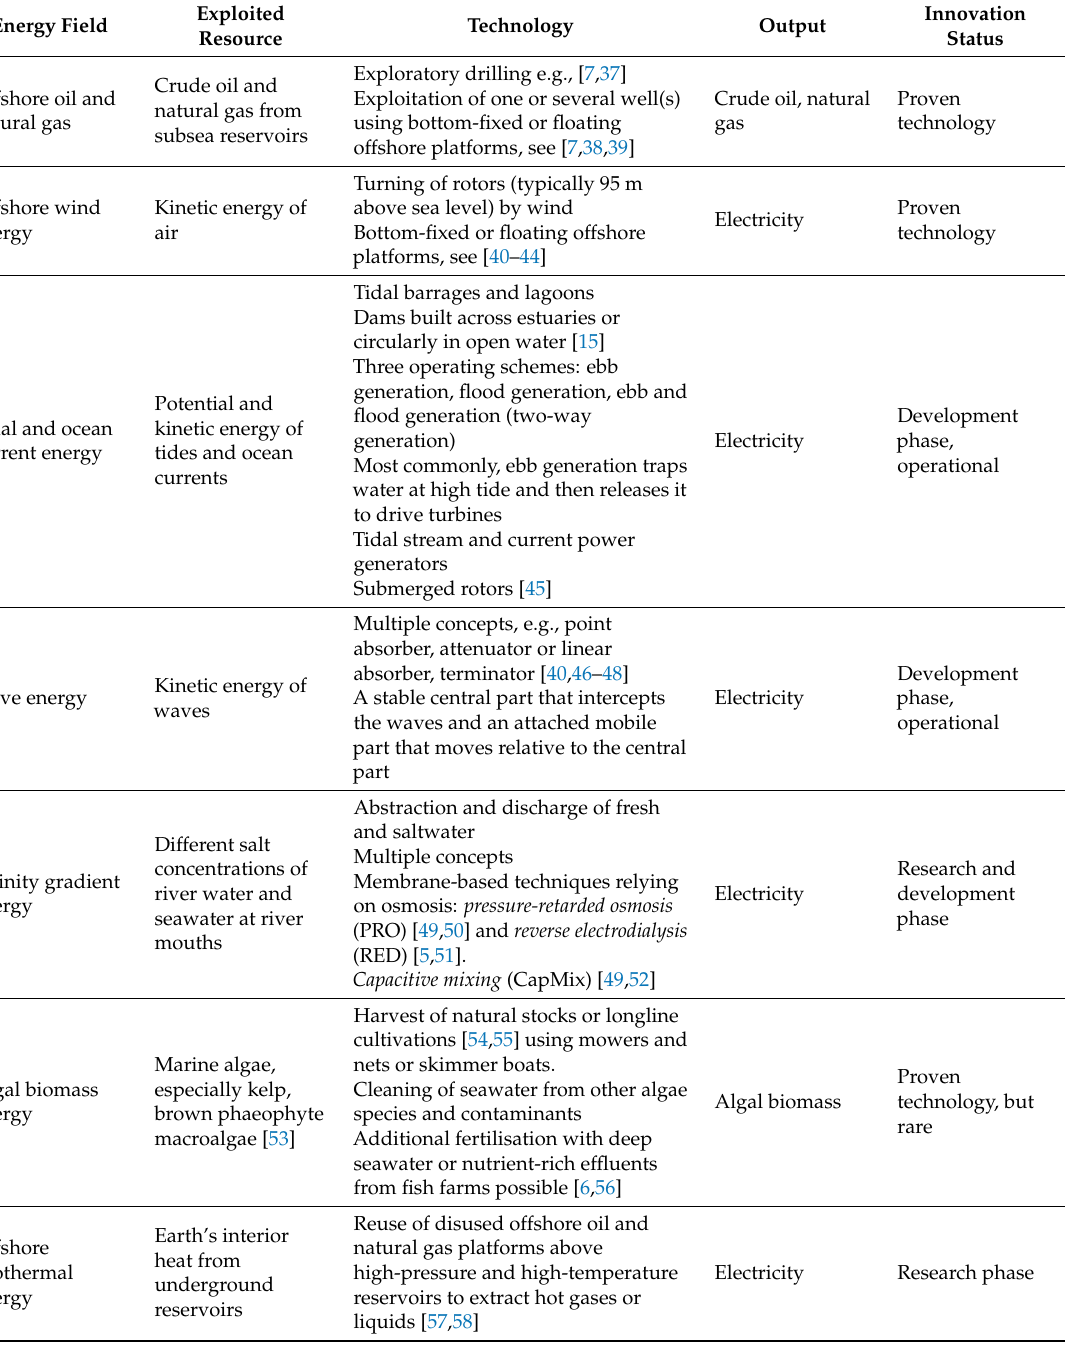
Table 2. Overview of reviewed offshore energy fields. For each field (rows), information on the exploited resource, technology, output, and innovation status in the North Sea is provided